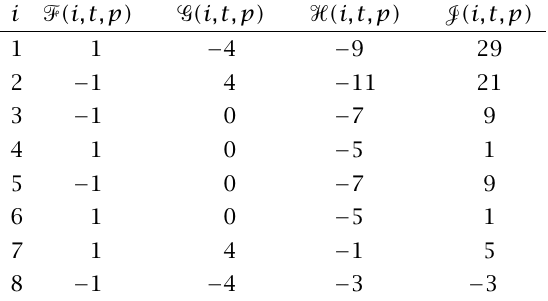
(cid:10) φ( − 1 ),φ(t),φ( 1 − t)